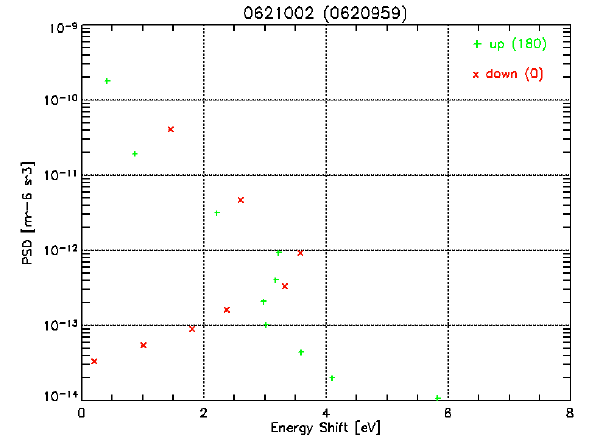
Fig. 8. Electron distribution function for electrons nearly parallel (full lines) and antiparallel (dotted lines, in green) and perpendicular (full lines, in red) to the spacecraft axis; bold lines: with 50 µ A beam current, thin lines: ASPOC off.